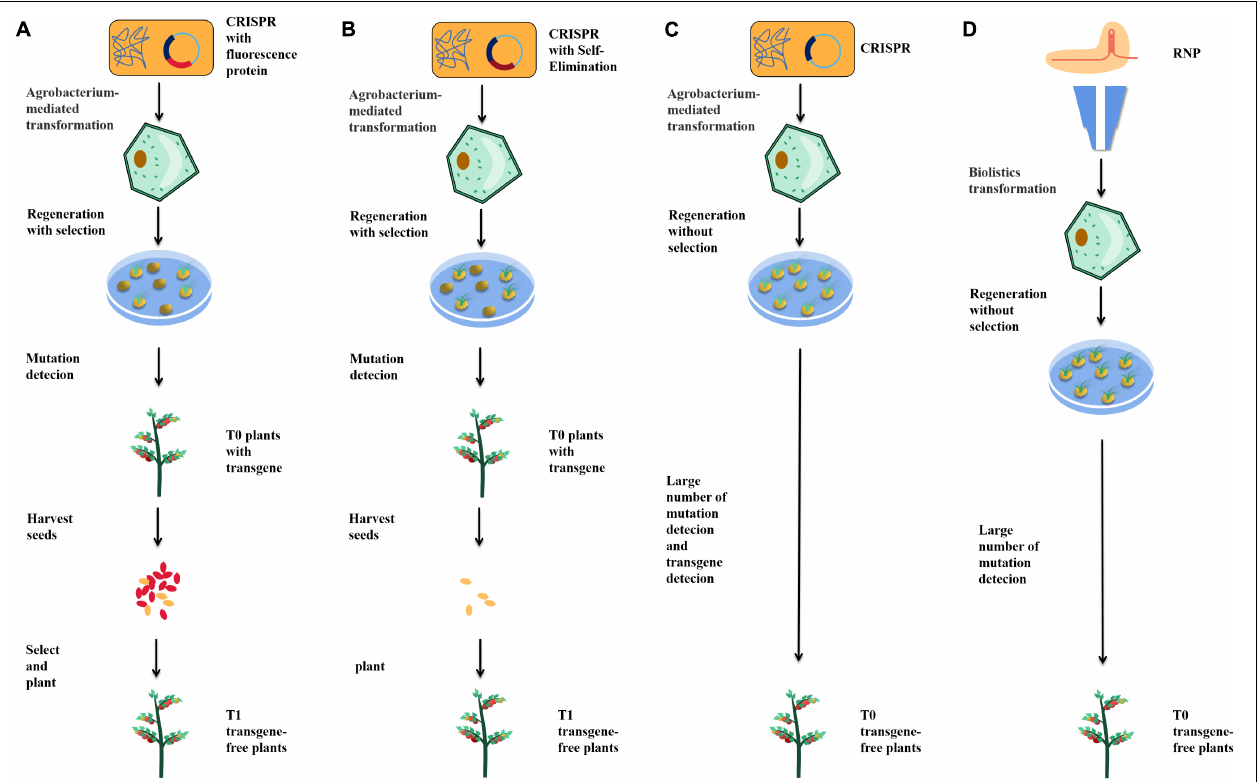
FIGURE 2 | Strategies to help obtain transgene-free plants. (A) Fluorescence labeling screening. (B) Self-elimination. (C) Agrobacterium mediate transient transgene expression. (D) Bombardment-mediated RNP delivery.